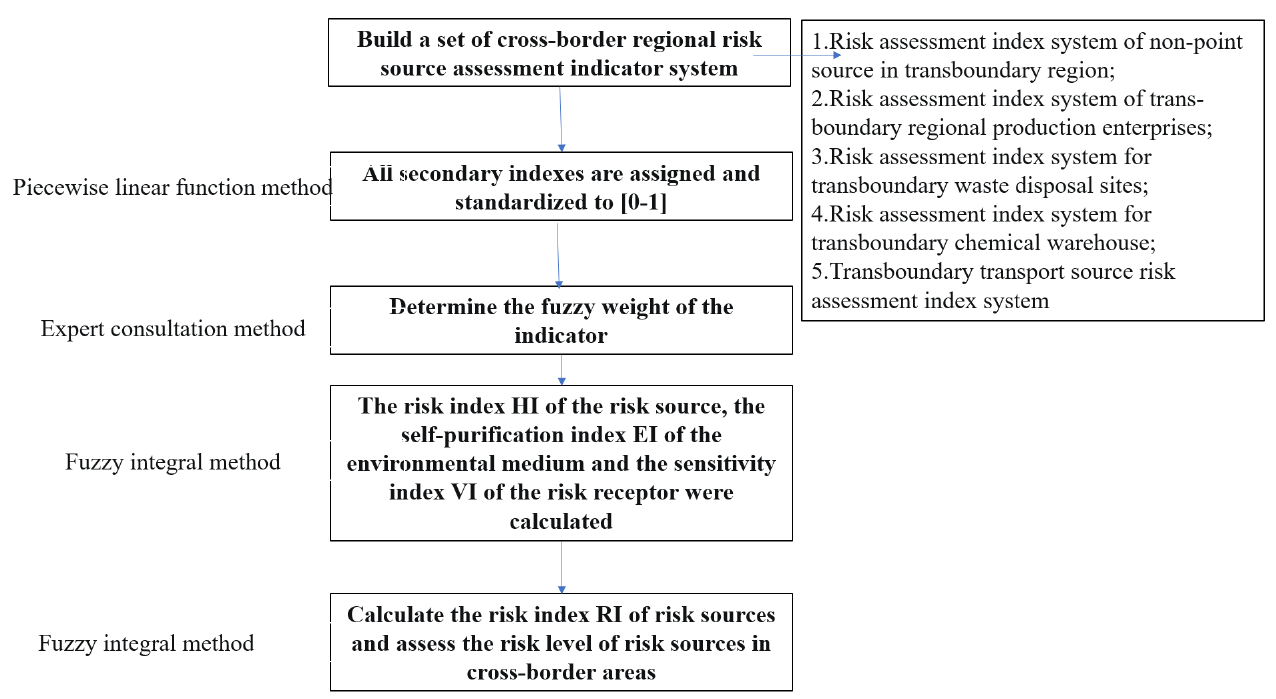
Figure 3. Flow chart of the risk assessment of risk sources in cross-border areas. Table 1. Risk assessment index system for production enterprises in the transboundary